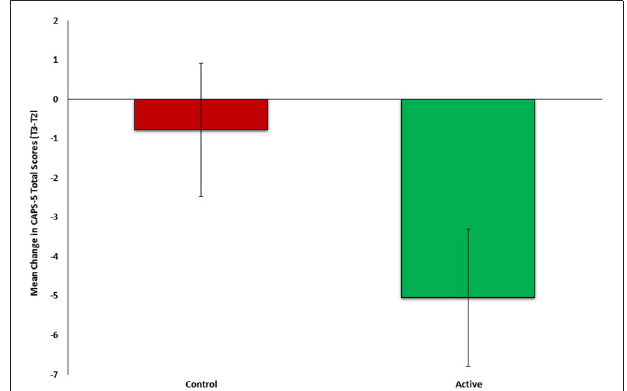
FIGURE 4 | Change in PTSD symptoms severity (CAPS-5, T3-T2) as a function of the change in cognitive flexibility (T2-Tl) among individuals in both active and control groups of Study 2 ( n = 49).